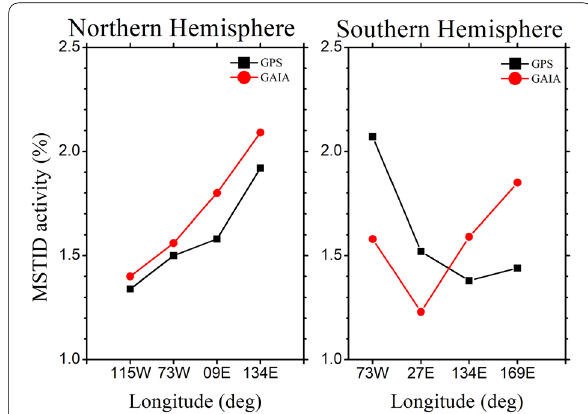
Fig. 6 Comparison of longitudinal variation of daytime MSTID activity during the maximum occurrence period (i.e. January in northern hemisphere and July in southern hemisphere) in GPS observation (black lines) and GAIA simulation (red lines) in (left) NH (right) SH. Horizontal axis denotes longitude, and vertical axis represents the MSTID activity